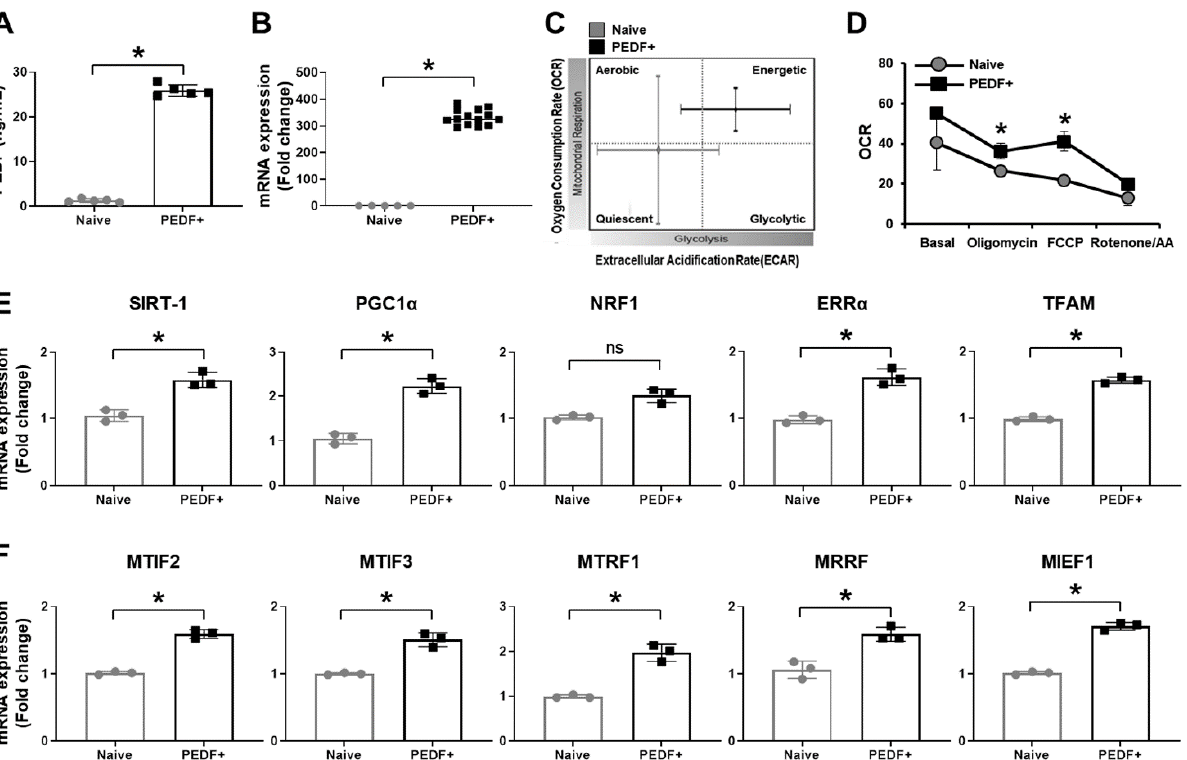
Figure 1. PD-MSCs PEDF enhance mitochondrial activity. ( A ) Secreted PEDF in the cell culture supernatants of naïve PD-MSCs (Naïve) and PD-MSCs PEDF (PEDF+) was analyzed by ELISA. OD = 450 nm. ( B ) The mRNA expression of PEDF was measured by qRT-PCR. ( C , D ) The OCR and ECAR levels of live Naïve and PEDF+ were analyzed by sequential treatment with 1 µ M oligomycin, 0.5 µ M FCCP, and 0.5 µ M rotenone/AA by a Seahorse XF24 real-time analyzer. qRT-PCR analysis of ( E ) mitochondrial biogenesis markers (e.g., SIRT-1, PGC1 α , NRF1, ERR α , and TFAM) and ( F ) mitochondrial translation markers (e.g., MTIF2, 3, MTRF1, MRRF, and MIEF1) in Naïve and PEDF+. The data from each group are shown as the mean ± SD and were analyzed by Student’s t -test. * p < 0.05 vs. Naïve.